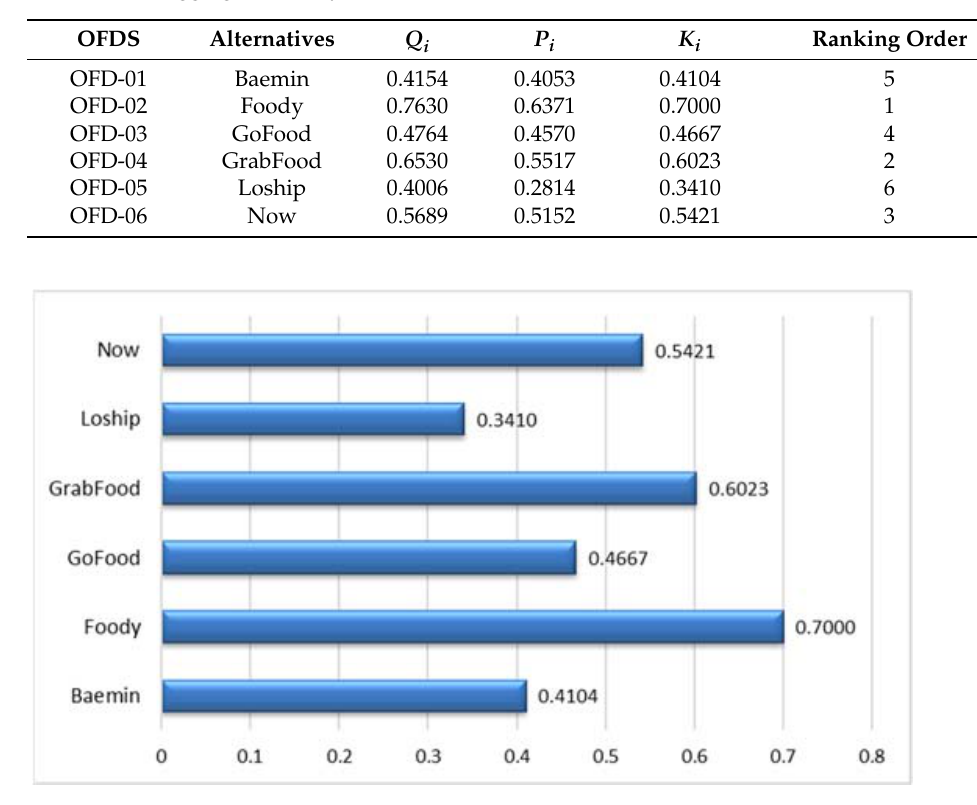
Figure 5. Final ranking order of WASPAS model.